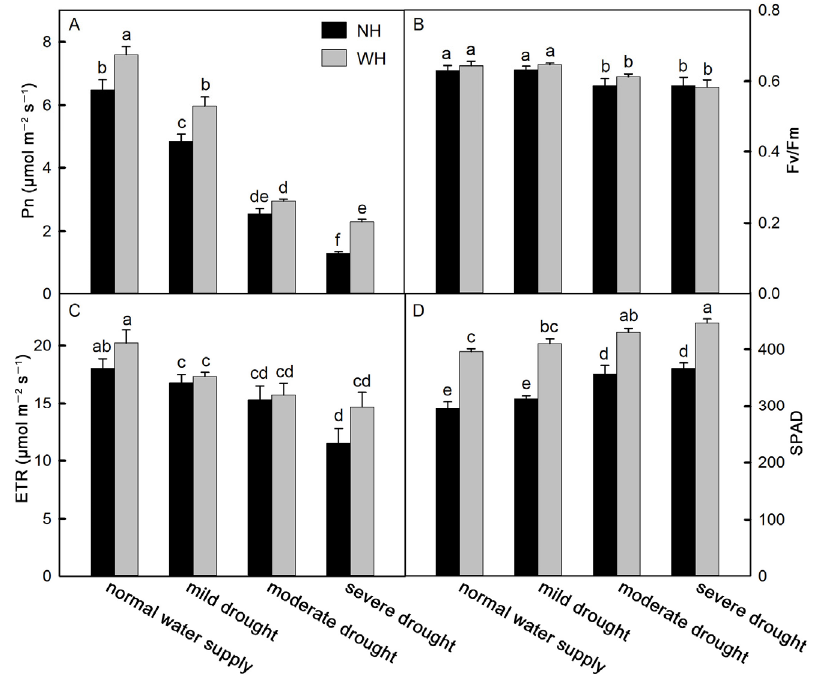
Figure 2. Net photosynthetic rate, maximum photochemical efficiency, electron current transfer rate, and SPAD. Effects of water and host on net photosynthetic rate (Pn, ( A )), maximum photochemical efficiency (Fv/Fm, ( B )), electron current transfer rate (ETR, ( C )), and SPAD ( D ) of S. album seedling leaves (means ± SE, n = 10). NH, grown without host; WH, grown with host. Different letters above bars indicate statistical significance ( p < 0.05).